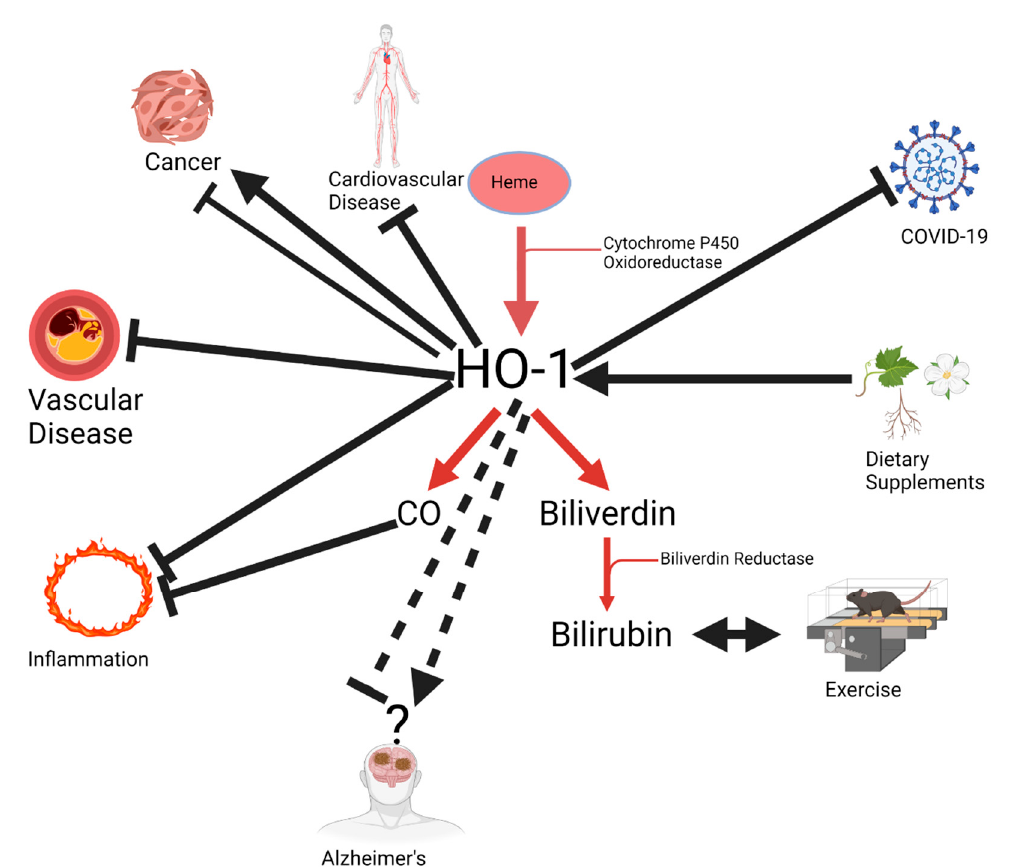
Figure 1. Pleiotropic effects of heme oxygenase-1 (HO-1). HO-1 has both stimulatory and inhibitory effects on cancer. It inhibits vascular disease, inflammation, COVID-19, and cardiovascular disease. It can be upregulated by a wide variety of dietary supplements. Enhancement of HO-1 activity increases carbon monoxide, which is a potent anti-inflammatory molecule, and increases the levels of bilirubin which are also augmented by exercise. Arrows indicate increased activity, lines with bars indicate inhibitory actions, and dashed lines indicate unknown function. Figure created with Bioren- der.com.